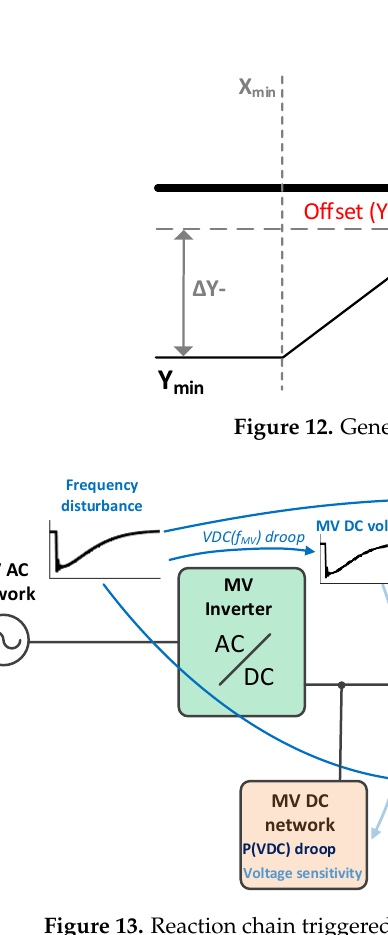
Figure 13. Reaction chain triggered following a frequency disturbance in the MV AC